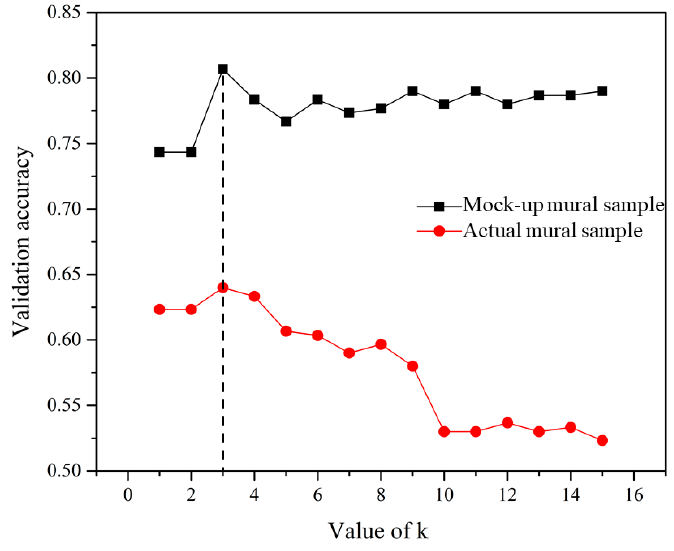
Figure 5. Validation accuracy of KNN with different K values.